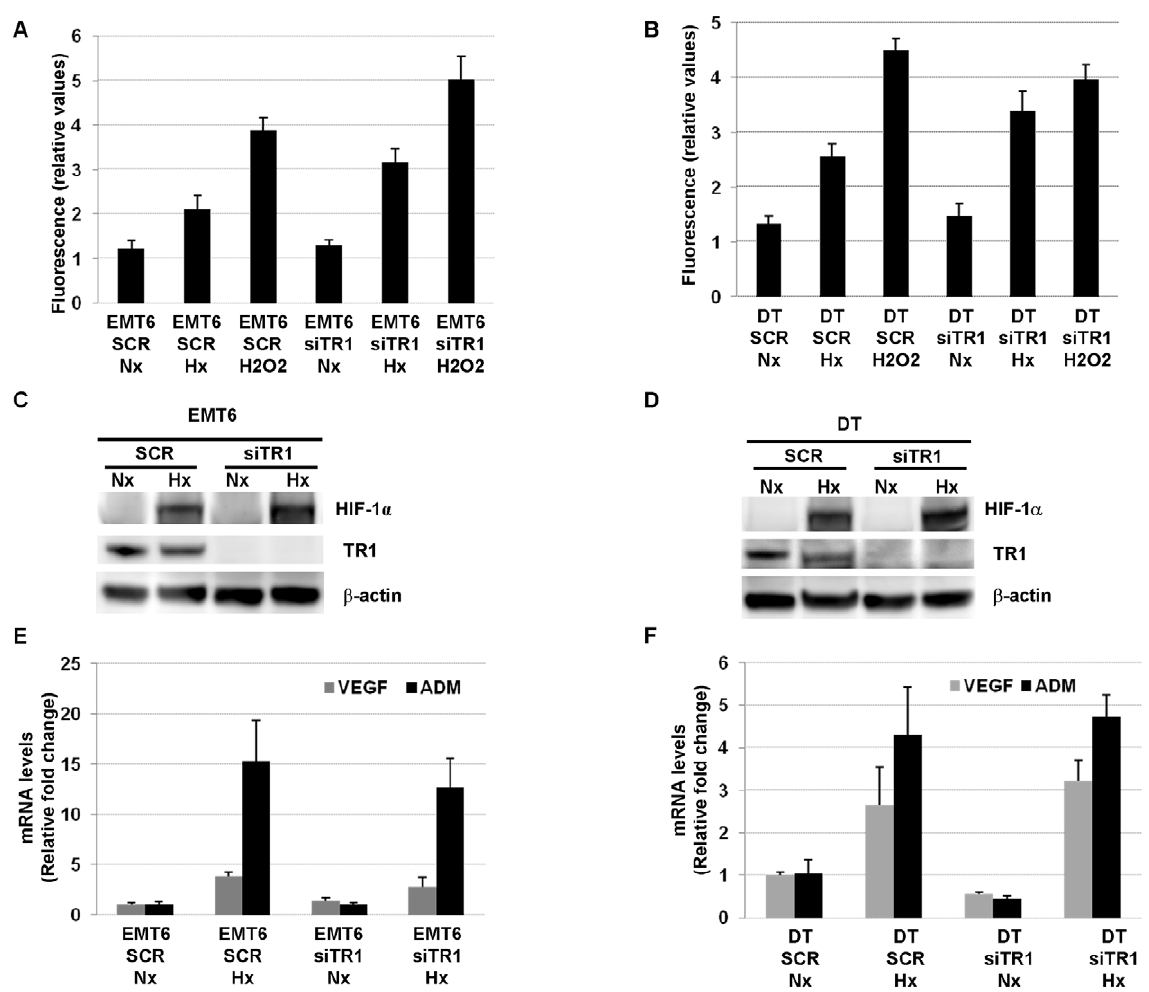
Figure 5. Effect of TR1 deficiency on ROS levels and HIF activity in cells cultured under hypoxic conditions. (A) EMT6 and (B) DT cells infected with retroviruses encoding a scramble sequence (SCR) or a TR1 shRNA (siTR1) were grown under normoxic (Nx) or hypoxic (Hx) conditions for 12 h and ROS levels determined as described in Methods. As a positive control for ROS generation, cells were treated with 100 m M of H 2 O 2 where indicated. Data represent the fluorescence value of each sample after subtracting the fluorescence value from unstained control cells. The mean 6 SE of 3–4 independent experiments is shown. HIF-1 a , TR1 and b -actin protein levels were determined by western blotting in (C) EMT6 and (D) DT cells infected with retroviruses encoding a scramble sequence (SCR) or a TR1 shRNA (siTR1) and cultured under normoxic (Nx) or hypoxic (Hx) conditions for 12 h. mRNA levels of the HIF target genes, VEGF and ADM, were analyzed by quantitative RT-PCR in (E) EMT6 or (F) DT cell lines infected with retroviruses encoding a scramble sequence (SCR) or a TR1 shRNA (siTR1) and cultured under normoxic (Nx) or hypoxic (Hx) conditions for 12 h. Data show the means of 3 independent experiments 6 SE.